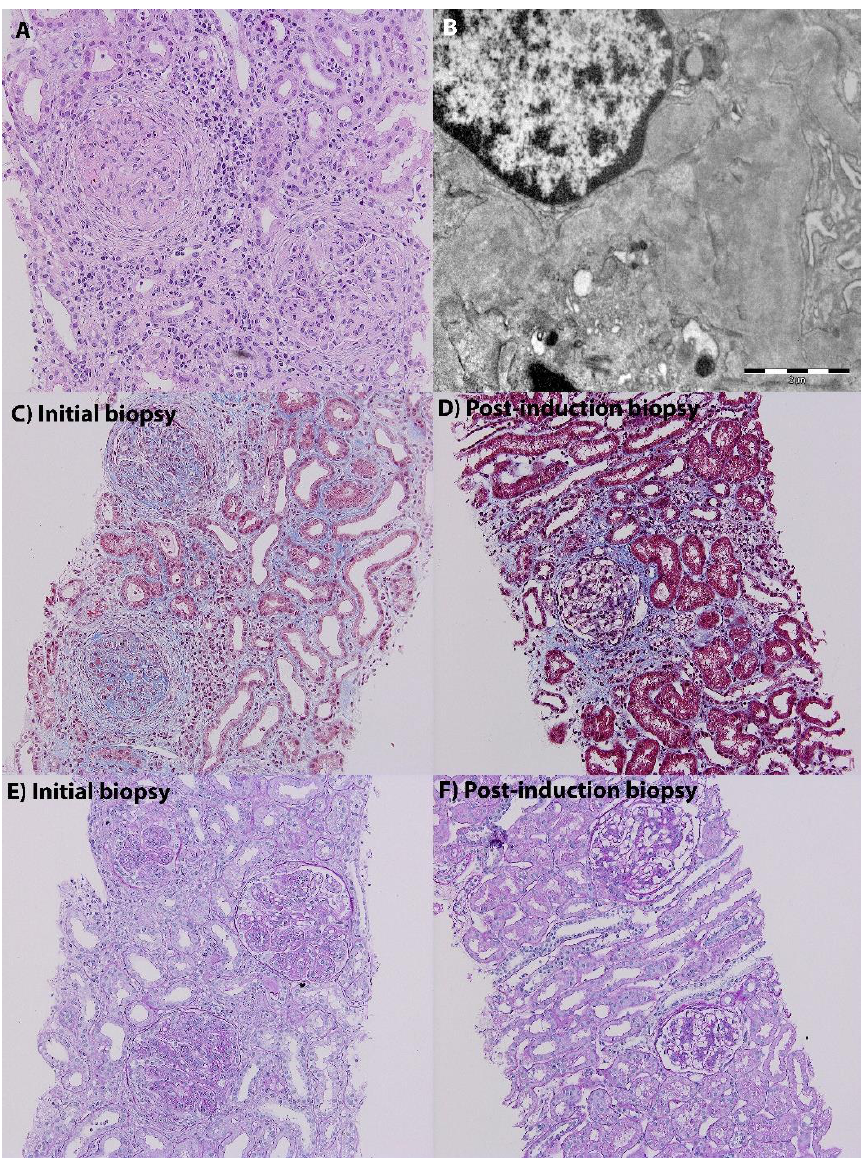
Figure 1. Patient 1 ( A , B ). Patient with SLE with normal renal function, 24-h proteinuria of 0.2 g/day, and minimal microscopic hematuria. Kidney biopsy shows severe, proliferative LN with crescent formation, and an activity index of 14 (( A ), haematoxylin eosin staining, magnification 20×), with extensive mesangial and subendothelial immune complex deposition (( B ), electron microscopy, magnification 11,000×). Patient 2, post-induction repeat biopsy (EUROLUPUS regimen). Initial biopsy, ( C ) (Masson staining, magnification 20×) and ( E ) (PAS staining, magnification 20×), show severe, proliferative LN with an activity index of 16 at baseline. Repeat biopsy, ( D ) (Masson staining, magnification 20×) and ( F ) (PAS staining, magnification 20×), show a significant histologic improvement with a decrease of the activity index to 2. (Images from the Renal Biopsy Registry of Fundeni Clinical Institute, Bucharest, Romania).